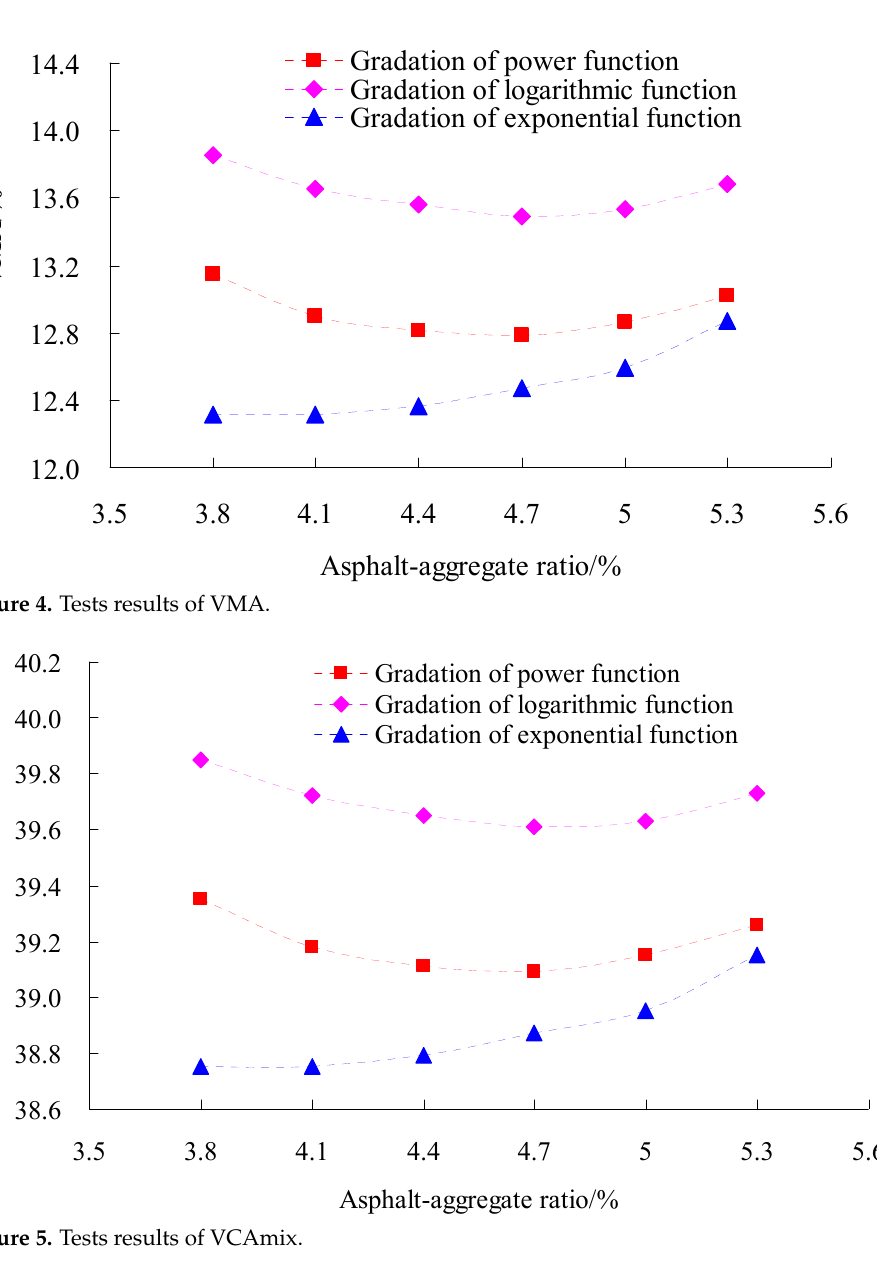
Figure 5. Tests results of VCAmix.